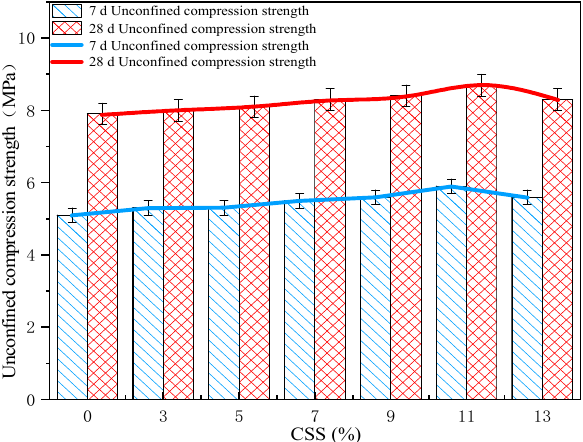
Figure 3. Different proportions of UCS at 7 d and 28 d.